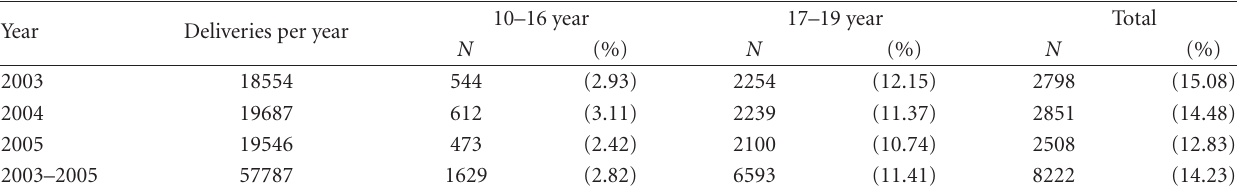
Table 2: Distribution of deliveries by year during the period of the